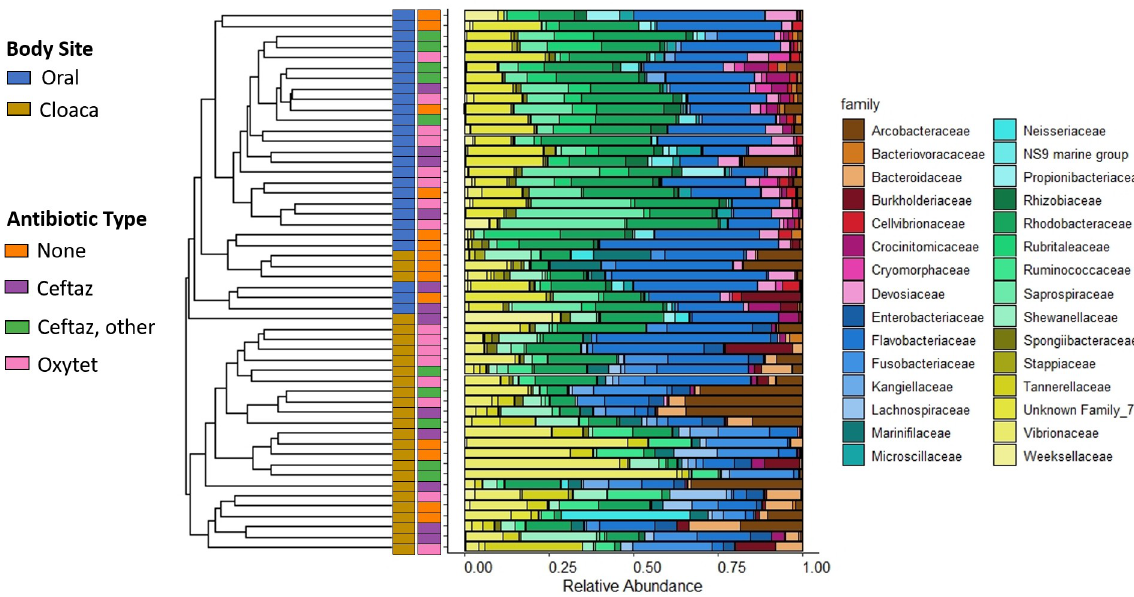
Fig 9. Turtle microbial communities at convalescence. Hierarchical clustering of convalescent samples (timepoint 4a) is shown as the dendrogram on the left, with the tips each representing a sample. On the right are the corresponding stacked bar plots representing relative abundance of community composition at the family level (top 30 families). Colored bars at the center specify body site (left bar) and antibiotic type (right bar) corresponding to each sample.